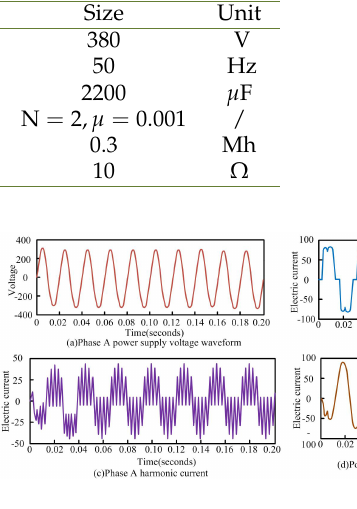
Fig. 8. Simulation model under voltage